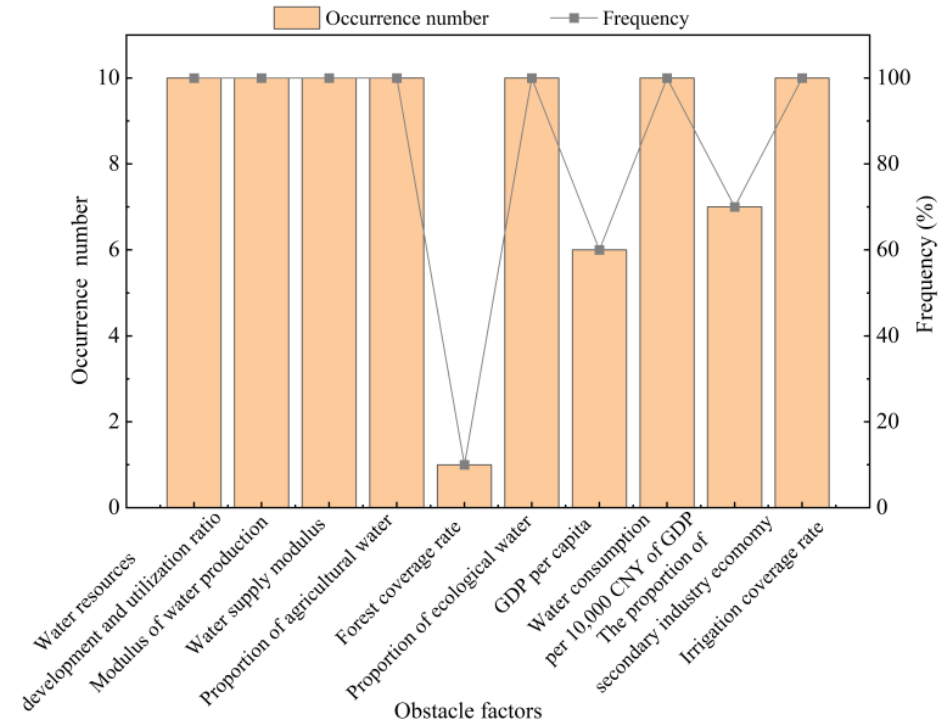
Figure 4. Frequency diagram of main obstacles to WRCC in Shihezi.